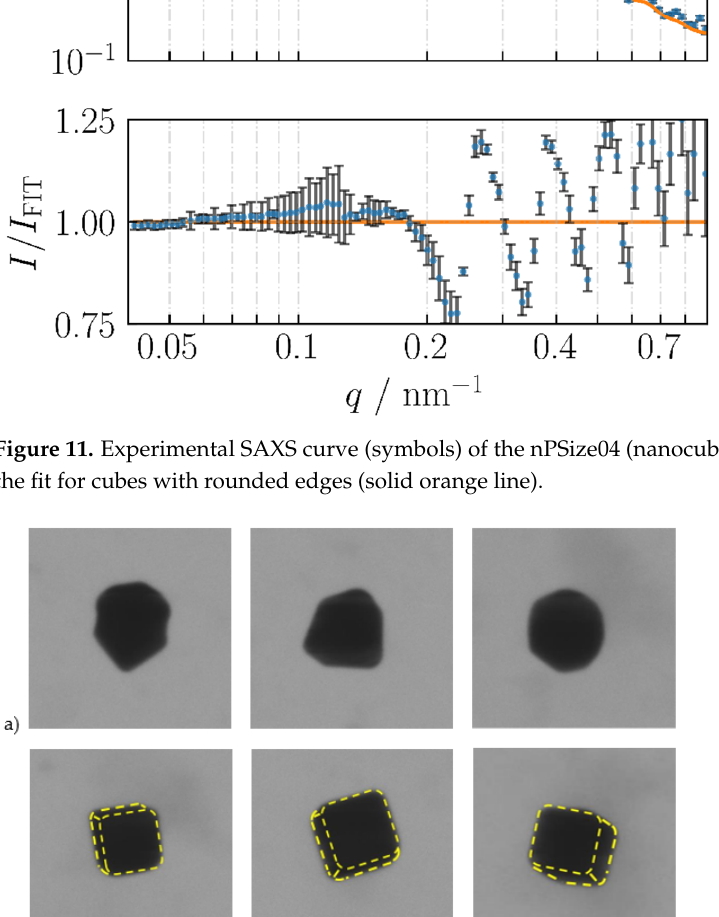
Figure 11. Experimental SAXS curve (symbols) of the nPSize04 (nanocubes) material together with the fit for cubes with rounded edges (solid orange line).